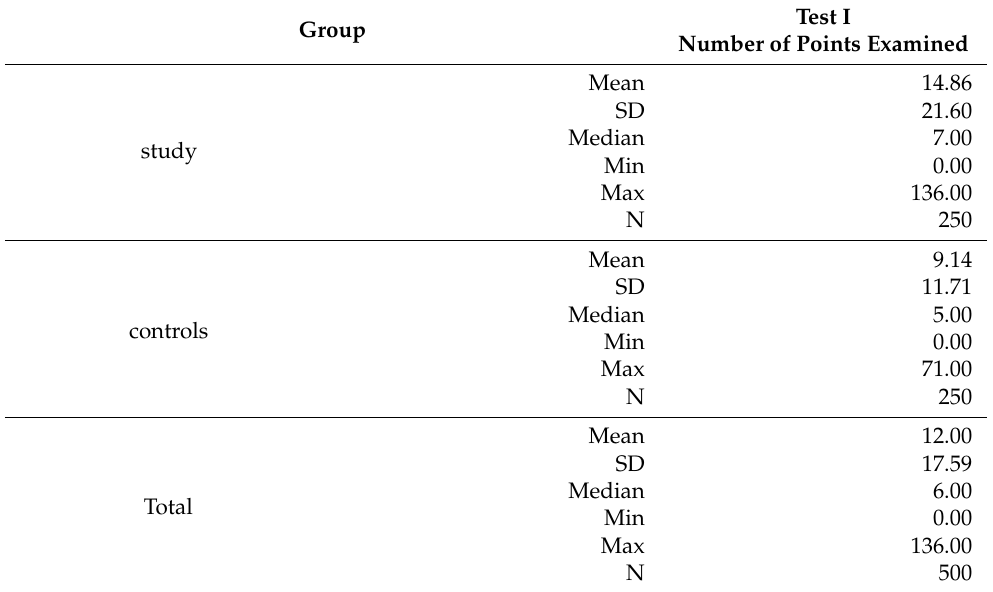
Table 3. Number of points marked in the tactile test—Test